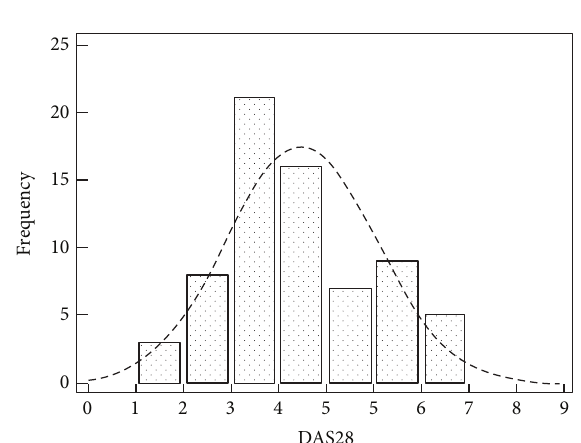
Figure 1: Estimates of central tendency and distributions of DAS28 in SLE patients.